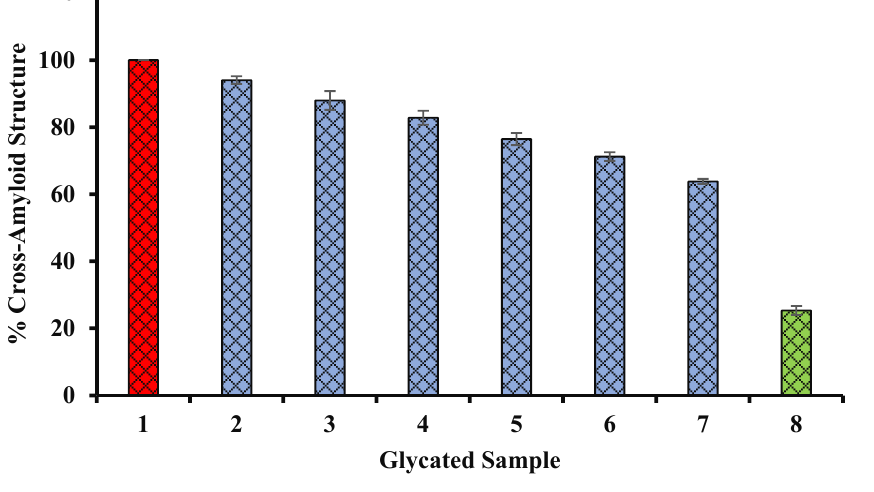
Figure 11. Decrease in cross amyloid structures in the presence of Ajwa seed extract (blue column). Sample 1 (red column) belongs to BSA kept with glucose for 15 days (100% structural modifications). Bars 2, 3, 4, 5, 6, and 7 show percent of structural modifications of glycated samples with 100, 200, 300, 400, 500, and 600 µ g/mL of Ajwa seed extract (blue columns), and structural modifications were found to be decreased with an increase in the concentration of seed extract. Bar 8 (green column) shows the structural modifications of BSA incubated in the absence of any extract or glucose, and exhibited the least structural modifications (glycation). The results are presented as means ± SEM ( n = 3, p < 0.05).